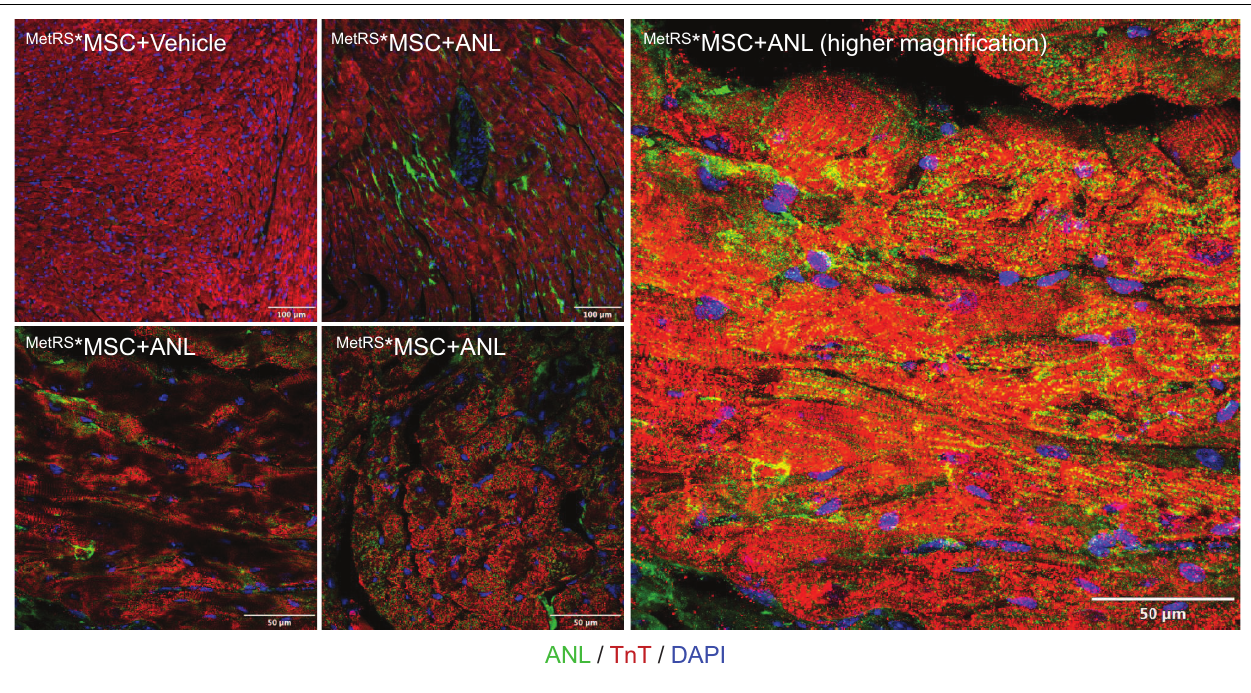
FIGURE 3 | Proteins from systemically administered MetRS ∗ MSC-Exos can be visualized in mouse hearts via click-catalyzed alkyne-Alexa Fluor 488 staining. Exosomes were isolated from the culture media of ANL- or vehicle-treated MetRS ∗ MSCs and injected into the tail vein of mice. Hearts were explanted 2 h later, sectioned, click-stained with reaction cocktails containing Alkyne-conjugated Alexa Fluor 488 (green), and counterstained with anti-Troponin T (red) and Hoechst (blue); regions of overlapping Alexa Fluor 488 and Troponin T fluorescence appear yellow.